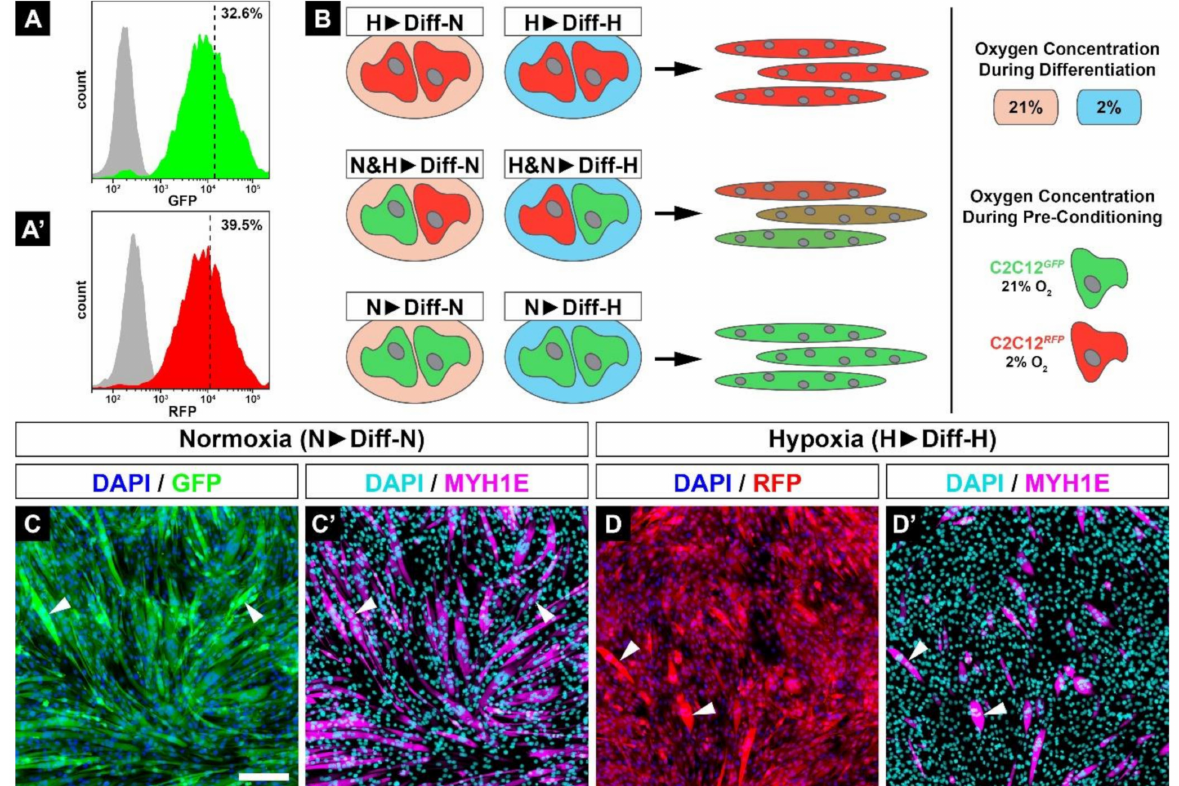
Figure 3. C2C12 cells were stably transfected with fluorescence proteins, sorted for high GFP ( A ) or RFP ( A’ ) fluorescence intensity by FACS, and afterwards continuously cultured at 21% (C2C12 GFP ) or 2% O 2 (C2C12 RFP ). Myogenic differentiation assays were performed with single or mixed colored cell lines. Thus, coloring depends on the fusion of various myoblasts populations, resulting in green (C2C12 GFP ), red (C2C12 RFP ), or dual-colored (C2C12 GFP/RFP ) myotubes ( B ). Immunocytochemistry against MYH1E shows that the newly generated reporter C2C12 cell lines kept their fusion abil- ity ( C’ , D’ ) and C2C12 RFP cells showed fusion deficiency in hypoxia ( D , D’ ) when compared with C2C12 GFP ( C , C’ ). Scale bar: 200 µ